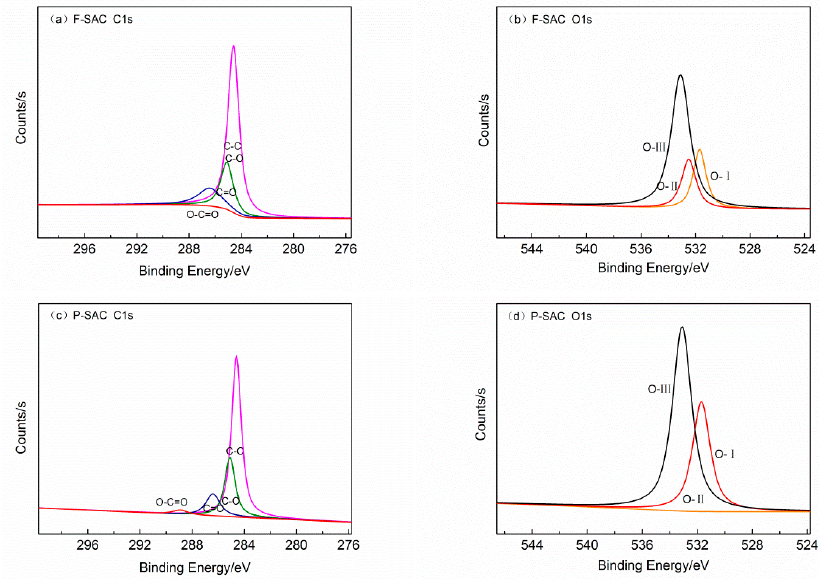
Figure 4. X-ray photoelectron spectroscopy (XPS) spectra of F-SAC and P-SAC. ( a ) F-SAC C1s; ( b ) F-SAC O1s; ( c ) P-SAC C1s; ( d ) P-SAC O1s.